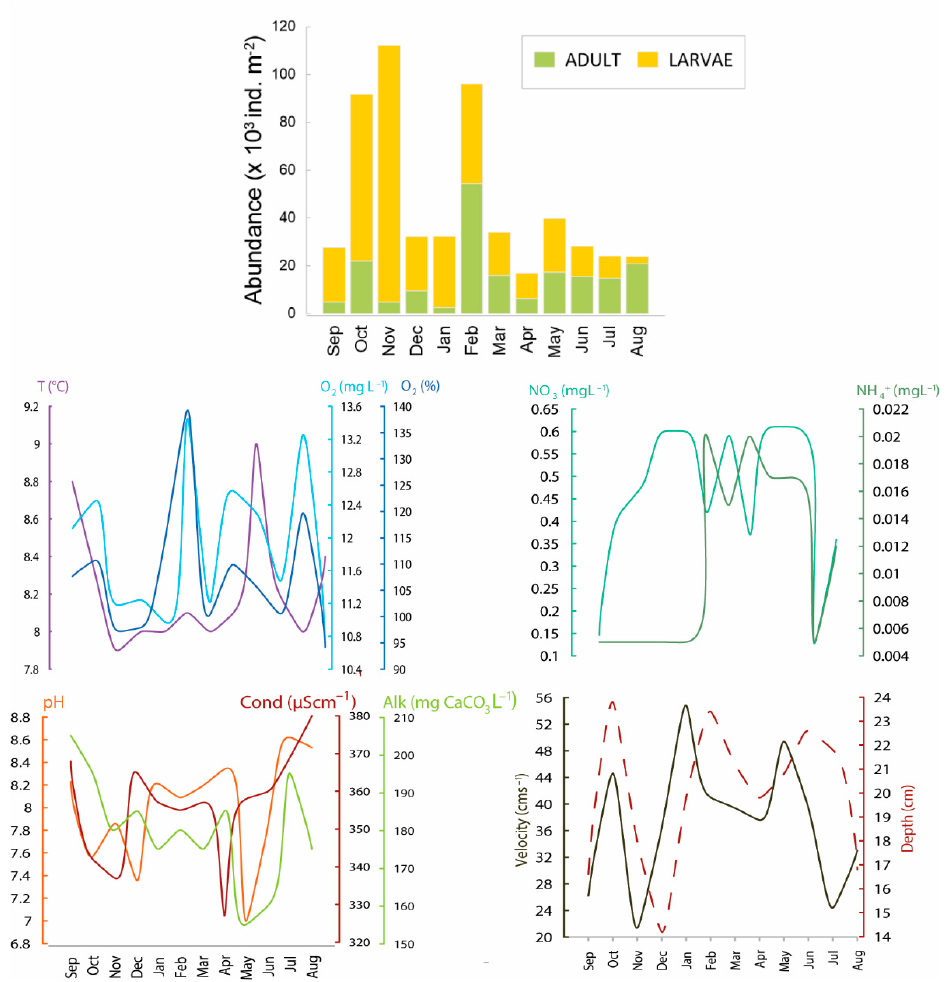
Figure 3. Environmental characteristics and seasonal dynamics of Elmis bosnica Zaitzev, 1908, in the Spring of the Bistrica River, Bosnia and Herzegovina. Abbreviations: T (°C), water temperature; O 2 (mg L − 1 ), dissolved oxygen; O 2 (%), oxygen saturation; Cond (µS cm − 1 ), conductivity; Alk (mg CaCO 3 L − 1 ), alkalinity; NO 3 (mg L − 1 ), nitrates; NH 4+ (mg L − 1 ), ammonium ions.